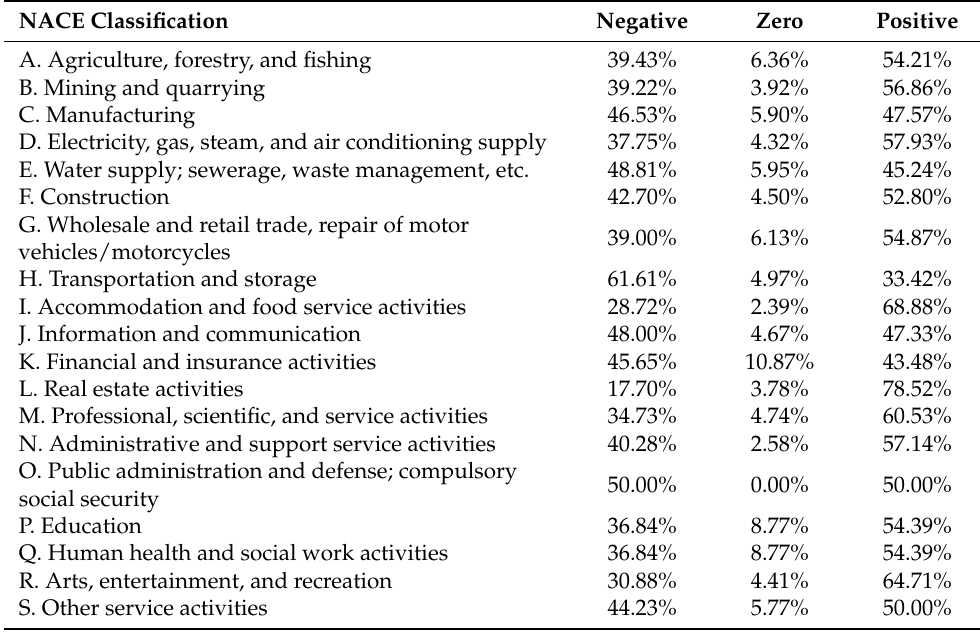
Table 6. Discretionary accrual levels across the sectors (period